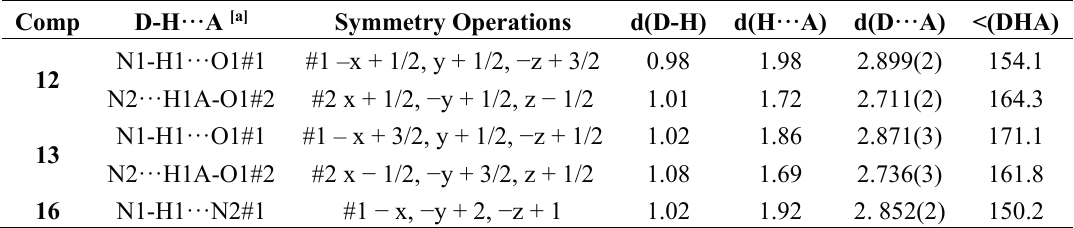
Figure 5. View of the packing for 12 showing the tetrameric units. Table 3. Hydrogen bonds (Å and °) for compounds 12 , 13 and 16